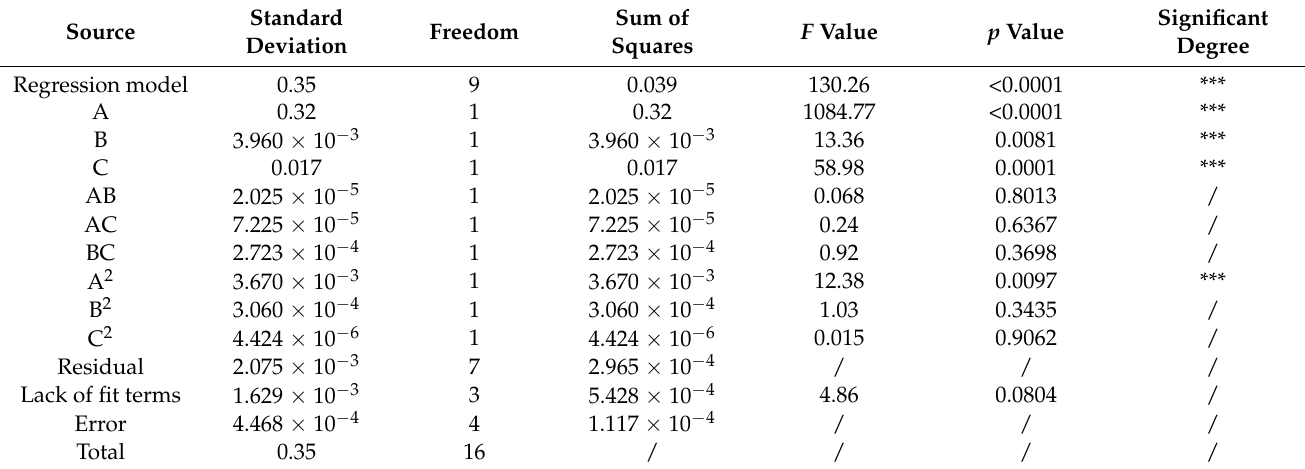
Table 9. ANOVA of the oilseed rape threshing loss rate.